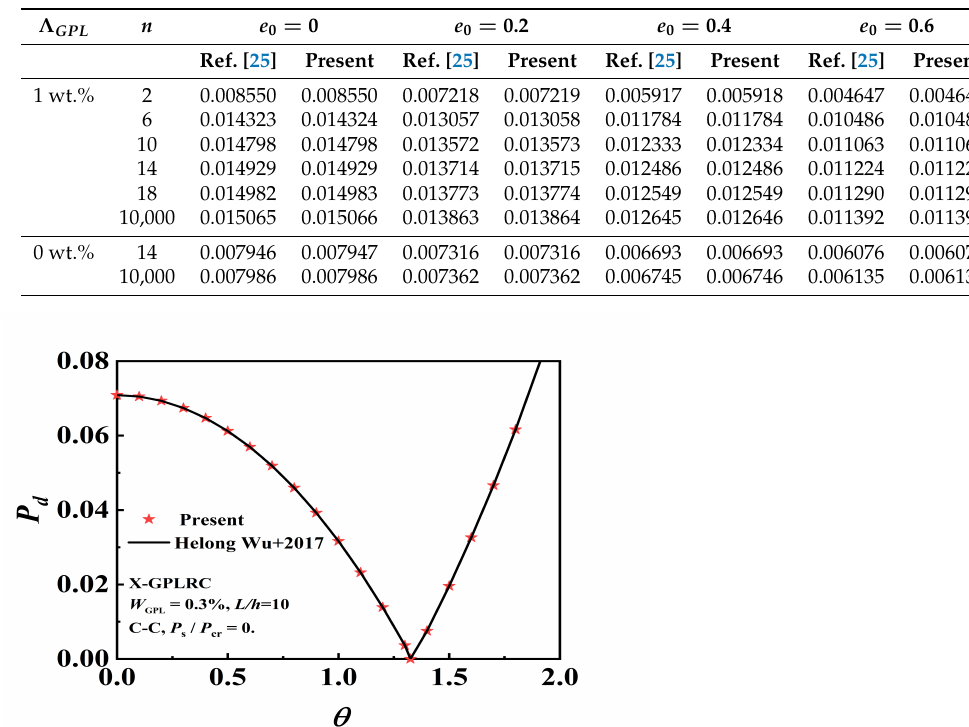
Table 2. The dimensionless critical buckling load of C-C beams (porosity 1, GPL A, L / h = 20).